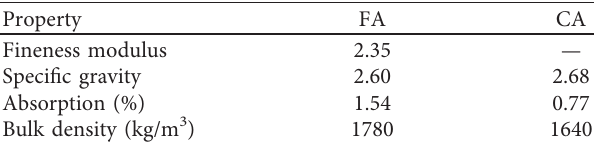
Table 2: Physical properties of the aggregate.